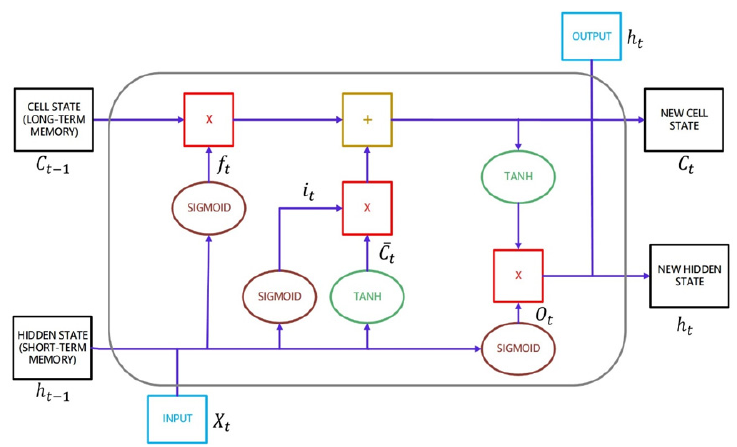
Figure 4. LSTM operational architecture.